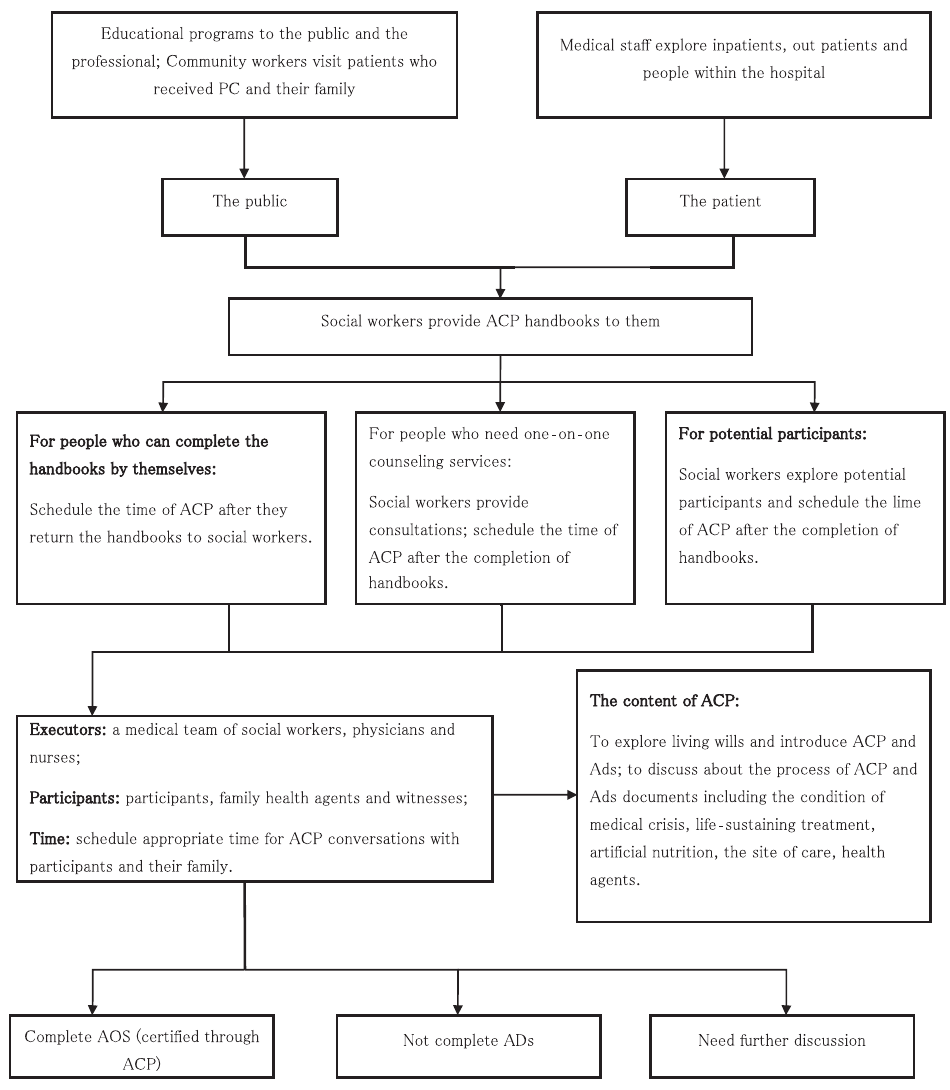
Figure 2. The process of ACP in Taiwan, China. Abbreviations: ACP, advance care planning; ADs, advance